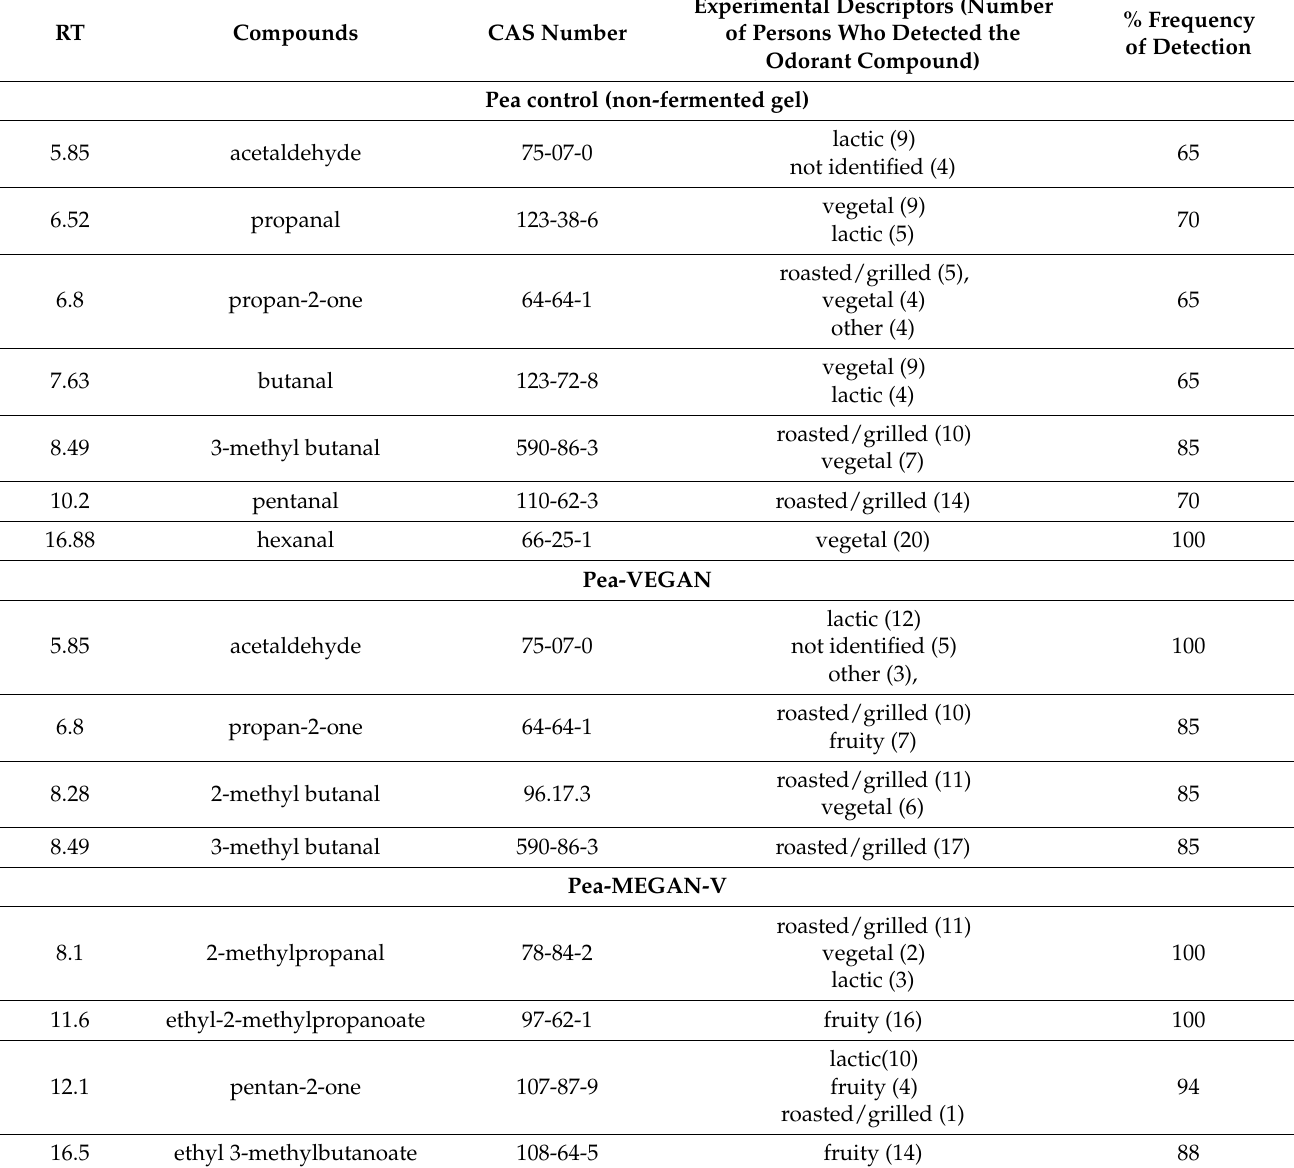
Table 1. Odorant compounds identified in the pea gels: control sample (not fermented gel) and pea VEGAN gels (after three days of